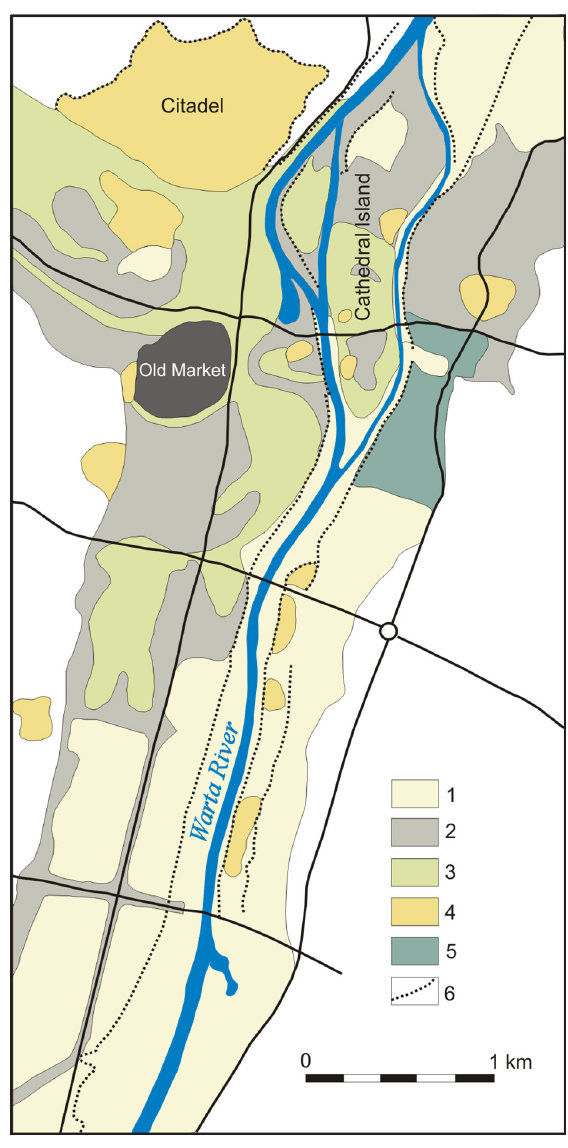
Fig. 4. Hypsometric changes of terrain surface as a result of levelling out works along the Warta River valley (kaniecki